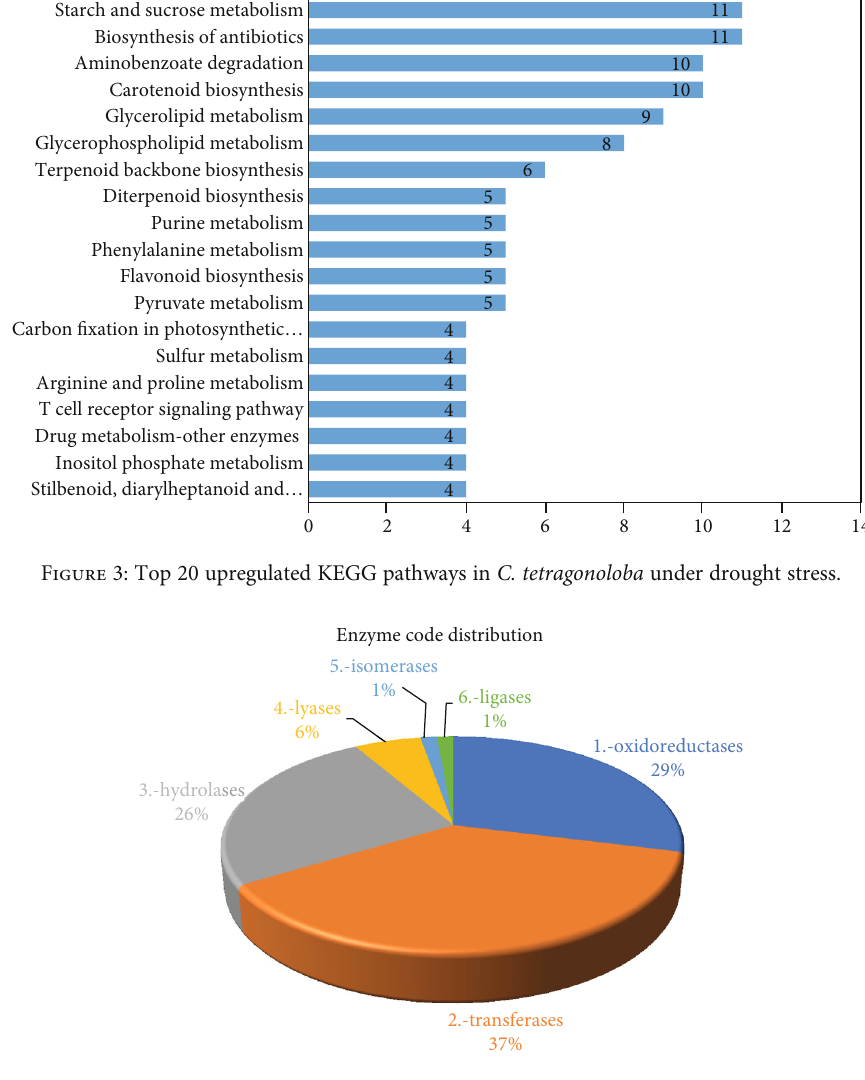
Figure 4: Upregulated enzyme codes (ECs) in C. tetragonoloba under drought stress.